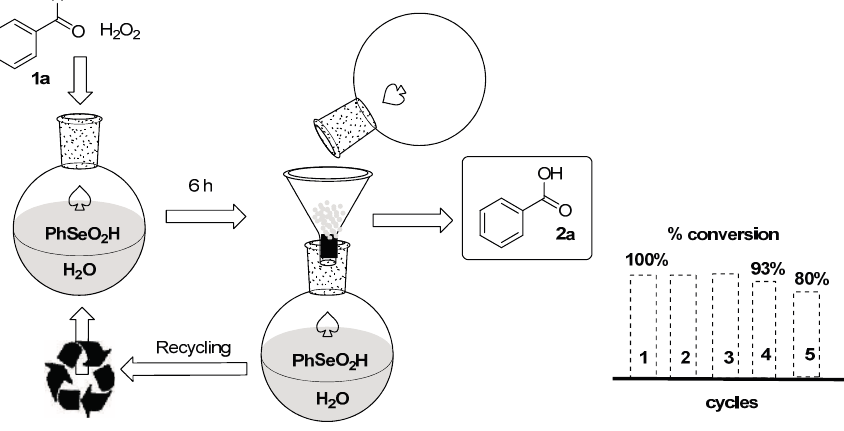
Figure 1. Recyclability of the aqueous medium and the catalyst in the synthesis of benzoic acid ( 2a